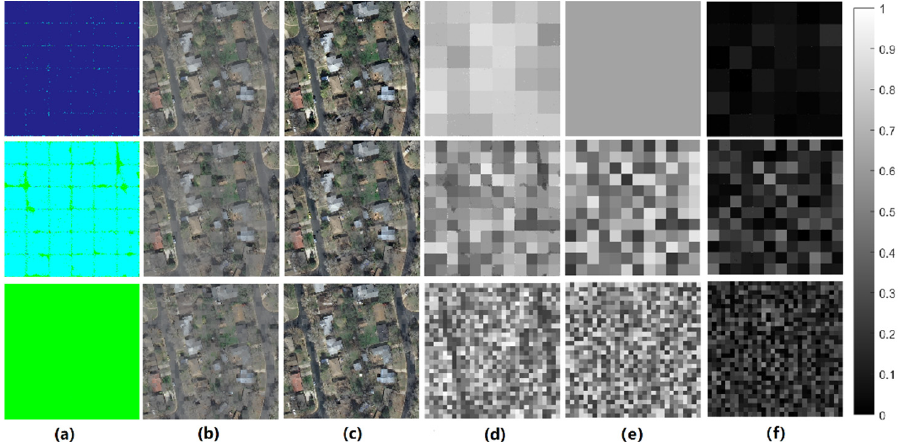
Figure 4. One-step DRL_Dehaze results for different haze scales in a residential area. The first row presents the uniform-haze situation, the second row presents the medium-scale haze situation, and the last row presents the small-scale haze situation. ( a ) Action maps of the hazy aerial images, ( b ) hazy aerial images, ( c ) dehazed clear image of ( b ), ( d ) predicted atmosphere transmission map, ( e ) ground truth values of the atmosphere transmission maps, and ( f ) differences in the predicted and true atmosphere transmissions. The bar on the right provides reference values for ( d )–( f ).